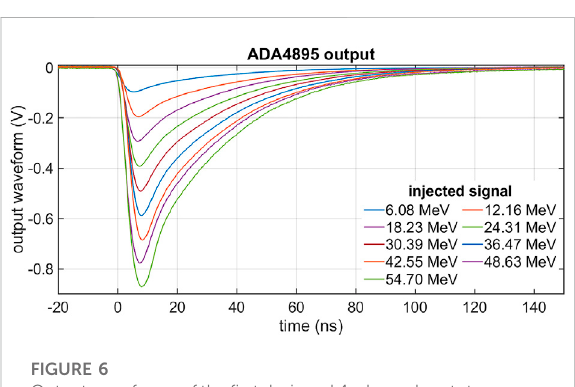
FIGURE 6 Outputwaveformsofthe fi rstdesigned 4-channelprototype, for different amplitudes of the electrical test signal.